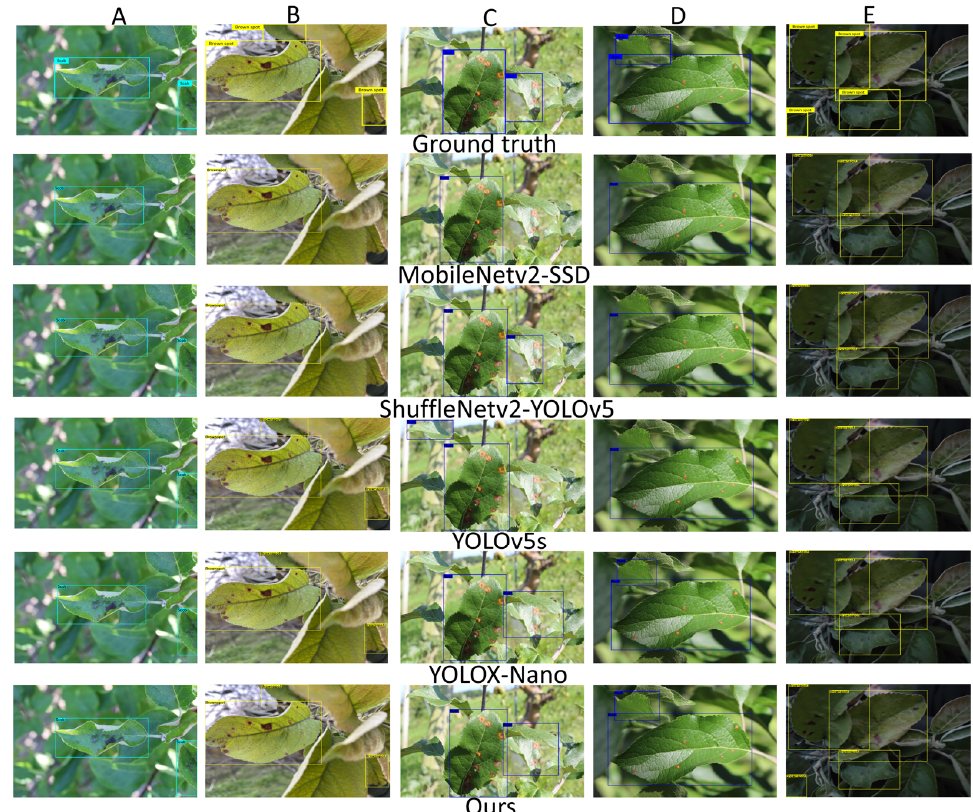
Figure 8. Visualization of detection results for different scenarios of the MSALDD. ( A ): Simple scenes; ( B ): obscured scenes; ( C ): Scenes in strong light; ( D ): Small target scenes; ( E ): Dim scenes.